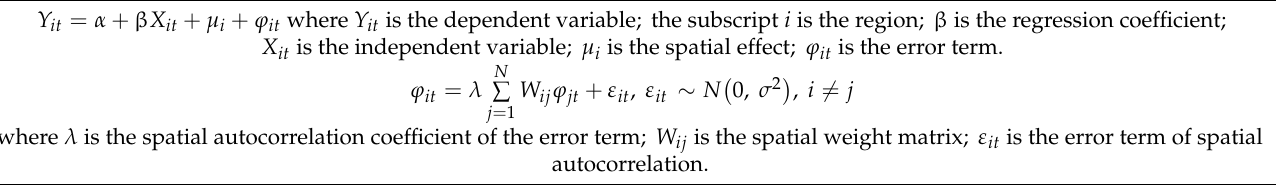
Table 7. The results of spatial Durbin model